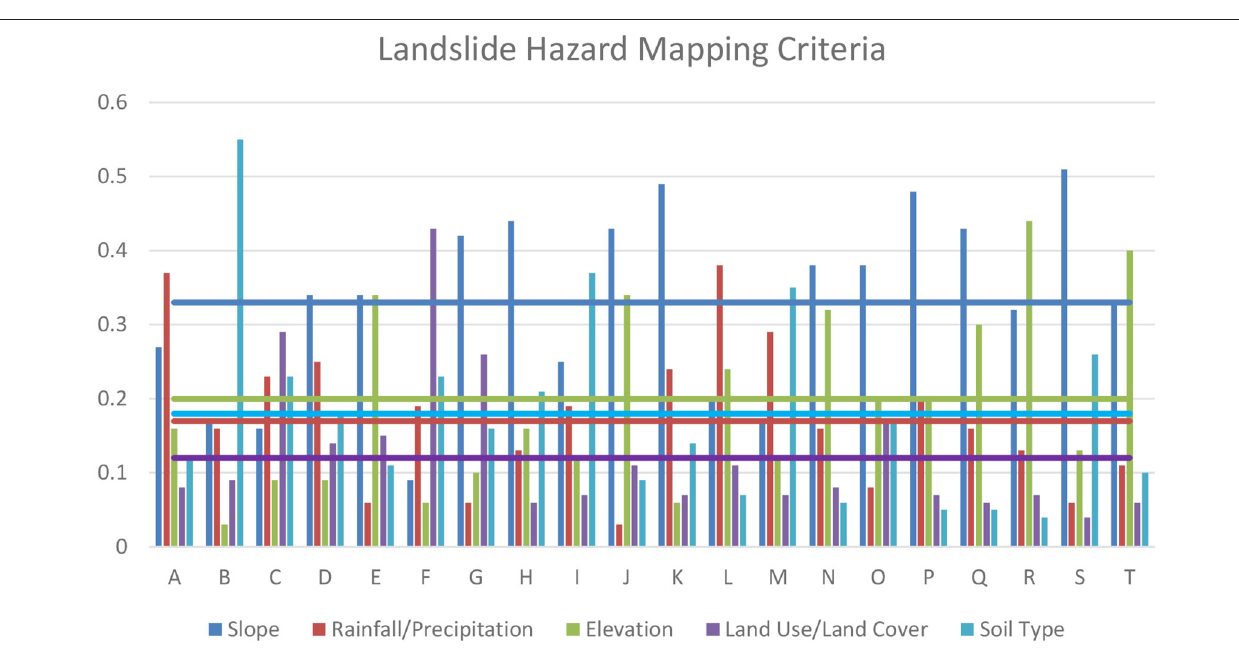
FIGURE 4 | Weights of the criteria for landslide hazard mapping using AHP showing the mean values in horizontal